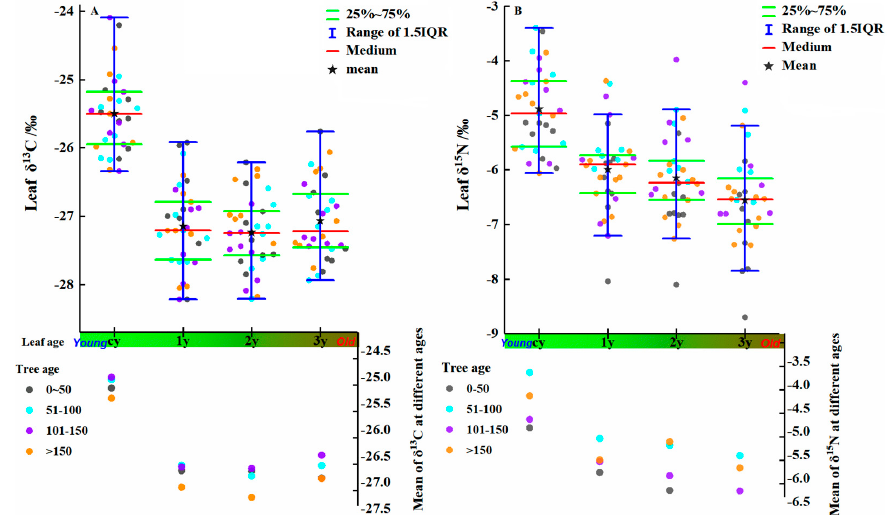
Figure 2. Box and scatter plots showing that the spatial patterns and variations of the δ 13 C ( A ) and δ 15 N ( B ) values changed with differently aged leaves and trees of P. crassifolia. Leaf ages including current year to 3-year-old leaves were represented by cy, 1y, 2y, and 3y, respectively.